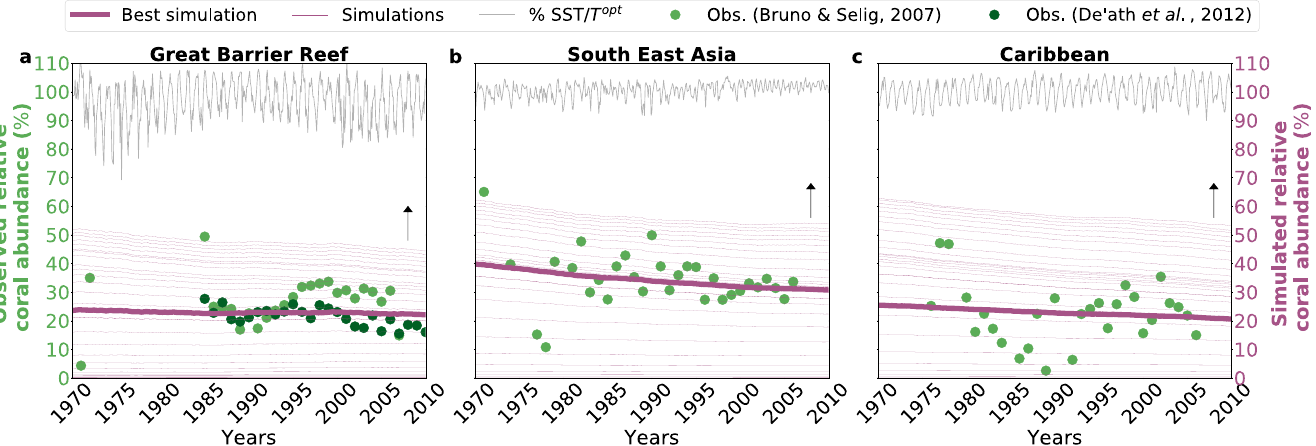
Fig 2. Model simulations at different speeds of acclimation. Model simulations (purple lines) are qualitatively compared to observations [61, 62], expressed as yearly median of coral abundances (green dots). The selected speed of acclimation, in each region (panels a , b , and c , respectively), is the one that produces results (thick purple line) consistent with observations. The arrows indicate the direction of increase in speed of acclimation and the thin grey lines indicate, for each region, environmental temperatures relative to corresponding optimal growth temperatures T opt .